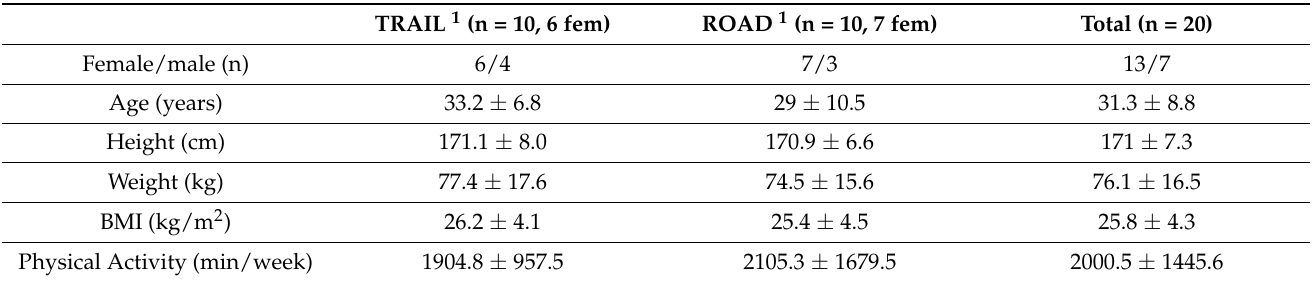
Table 1. Demographic data at